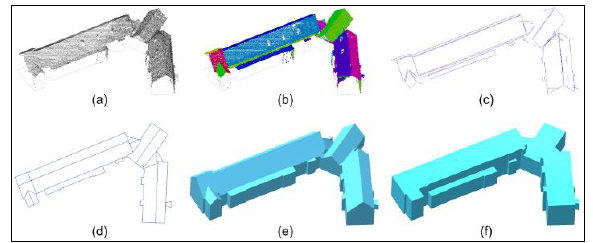
Figure 2. Main steps in the building reconstruction method: (a) input point cloud + input building footprint, (b) plane detection in point cloud, (c) roof boundary line detection, (d) roof partition, (e) LoD2.2 solid extrusion, (f) LoD1.3 solid extrusion.